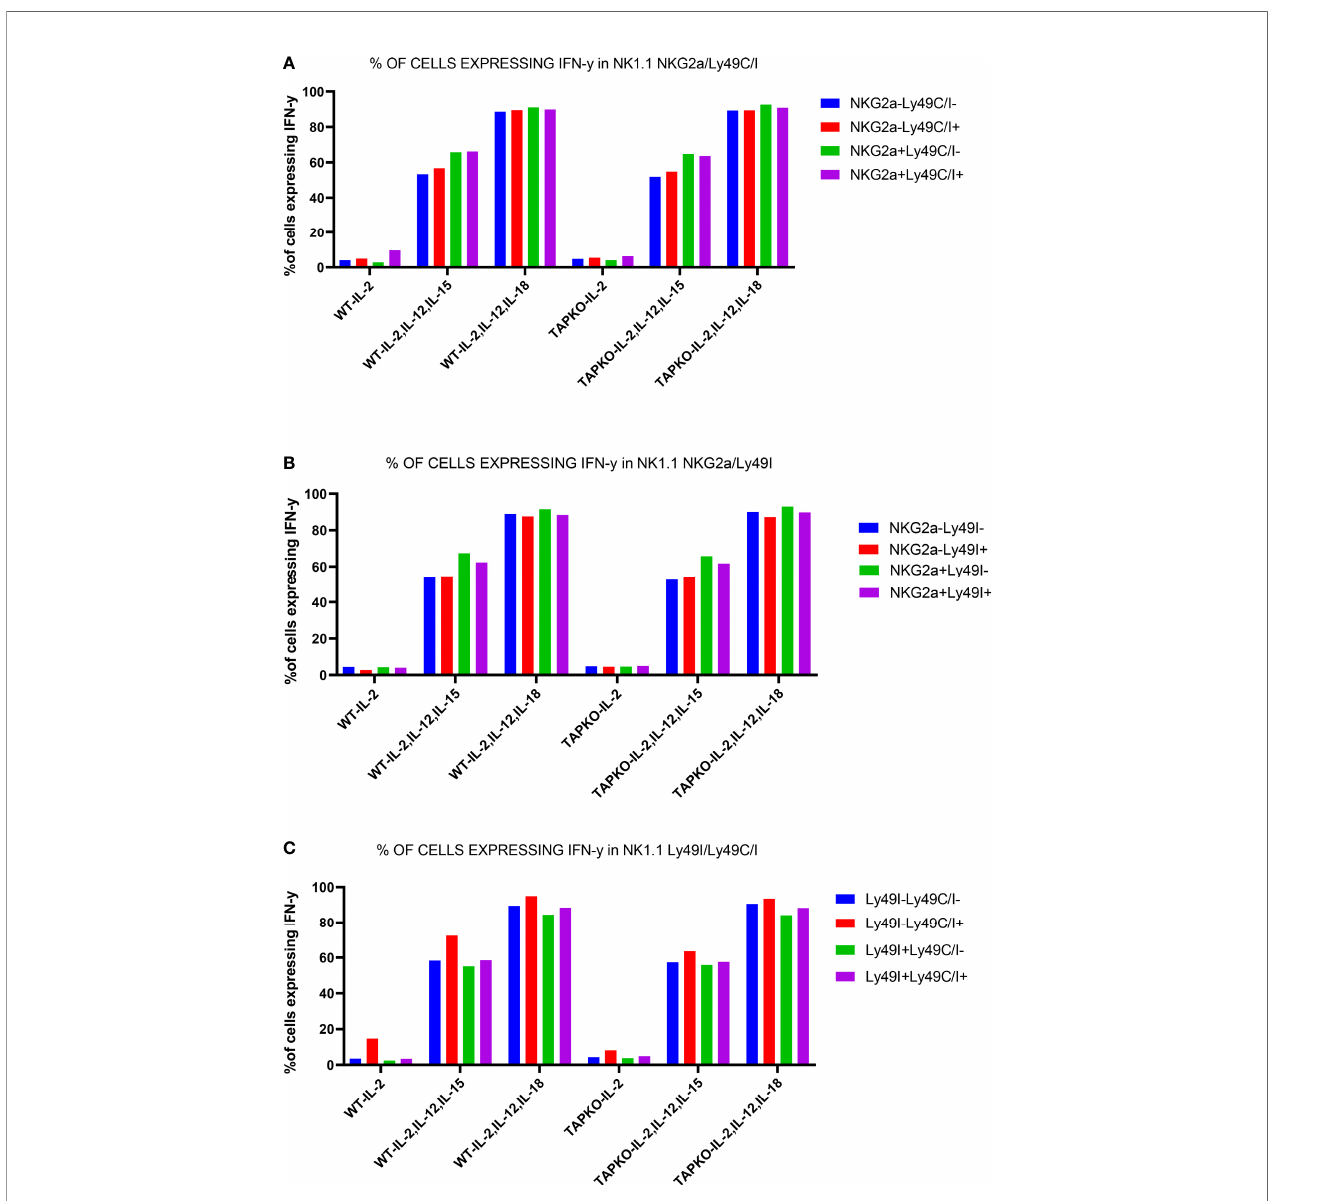
FIGURE 8 | One representative experiment out of two showing the educational impact of Ly49C, but not of Ly49I, at day 6 in cytokine-stimulated NK cells. (A) Comparison of IFN g production in CD3-NK1.1+ splenocytes activated with IL-2, (IL-2, IL-12, IL-15) and (IL-2, IL-12, IL-18) among the subsets de fi ned by the presence or absence of Ly49C/I and NKG2A. (B) The same readout for NK cells expressing or not the IR Ly49I and NKG2A. (C) Comparison of the differences in IFN g production in the NK cell subsets de fi ned by the presence or absence of Ly49C/I and Ly49I. The higher production in the Ly49C/I+ population suggests an educational impact of Ly49C under our activation conditions, but no or only a very weak in fl uence of